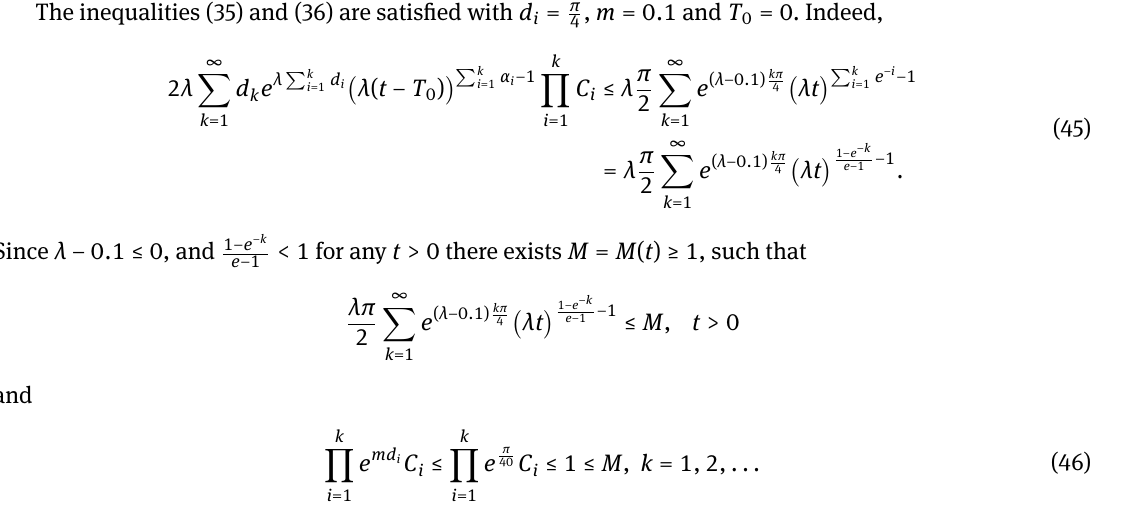
The inequalities (35) and (36) are satisfied with d i = π